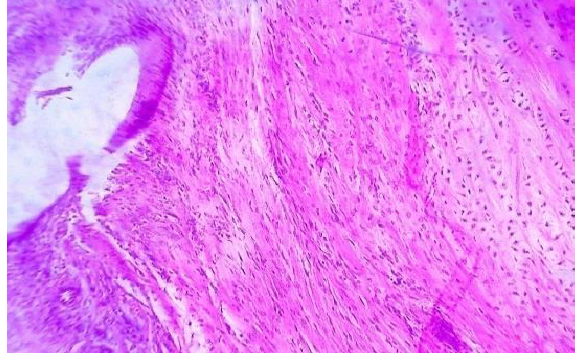
Figure, 13 : Digital photomicrograph of tracheal defect at 15 postoperative day in G1 shows new granulation tissue formation (collagen fibers, fibroblast) (H&EX10).